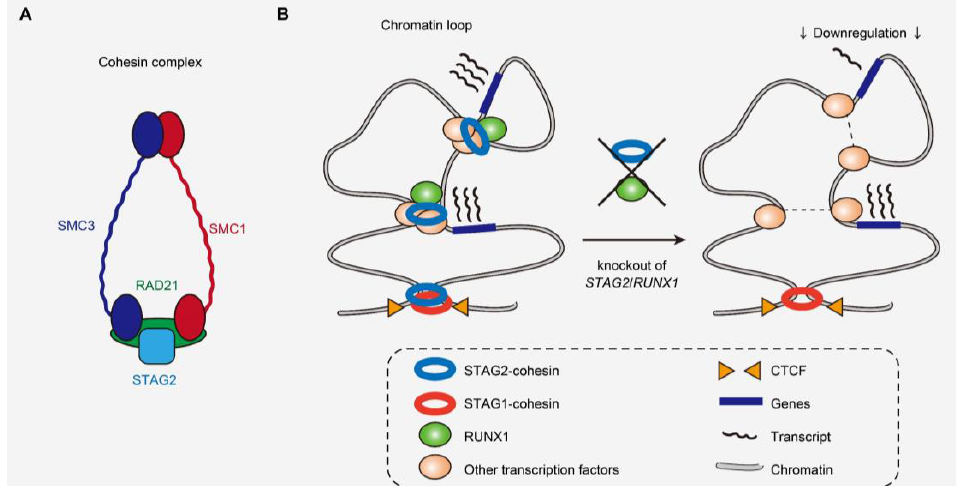
Figure 3. Cohesin complex and the 3D genome structure affected by cohesin and RUNX1 mutations. ( A ) Cohesin complex and its components frequently mutated in myeloid malignancies. ( B ) Scheme demonstrating the perturbation of short-range loops and deregulation of a subset of genes caused by loss of STAG2 and RUNX1 [22] .